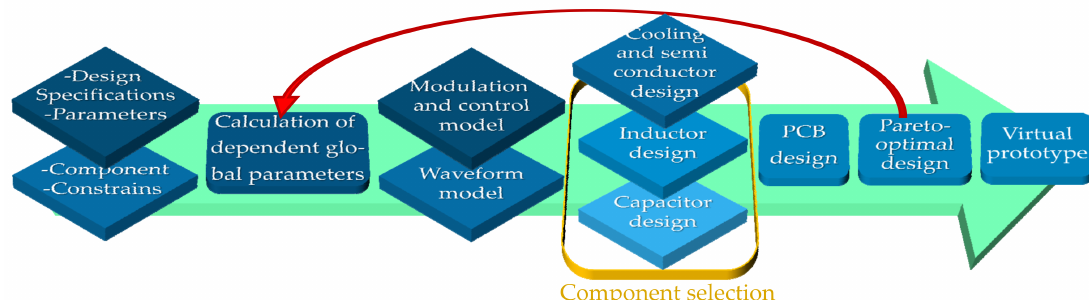
Figure 5. Simplified workflow of the virtual prototyping routine of the MODO-based process.